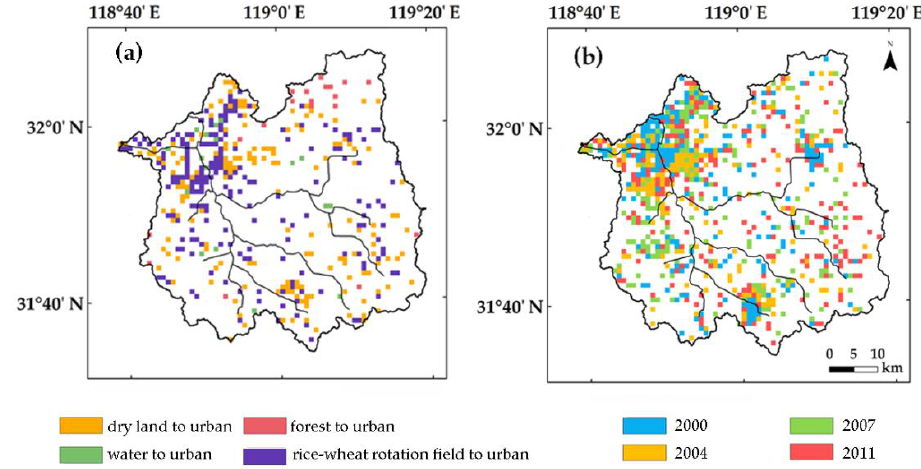
Figure 2. Land use change to urban from 2000 to 2013 ( a ) and urban area expansion in 2000, 2004, 2007, and 2011 ( b ). Each pixel has an area of 1 km 2 .